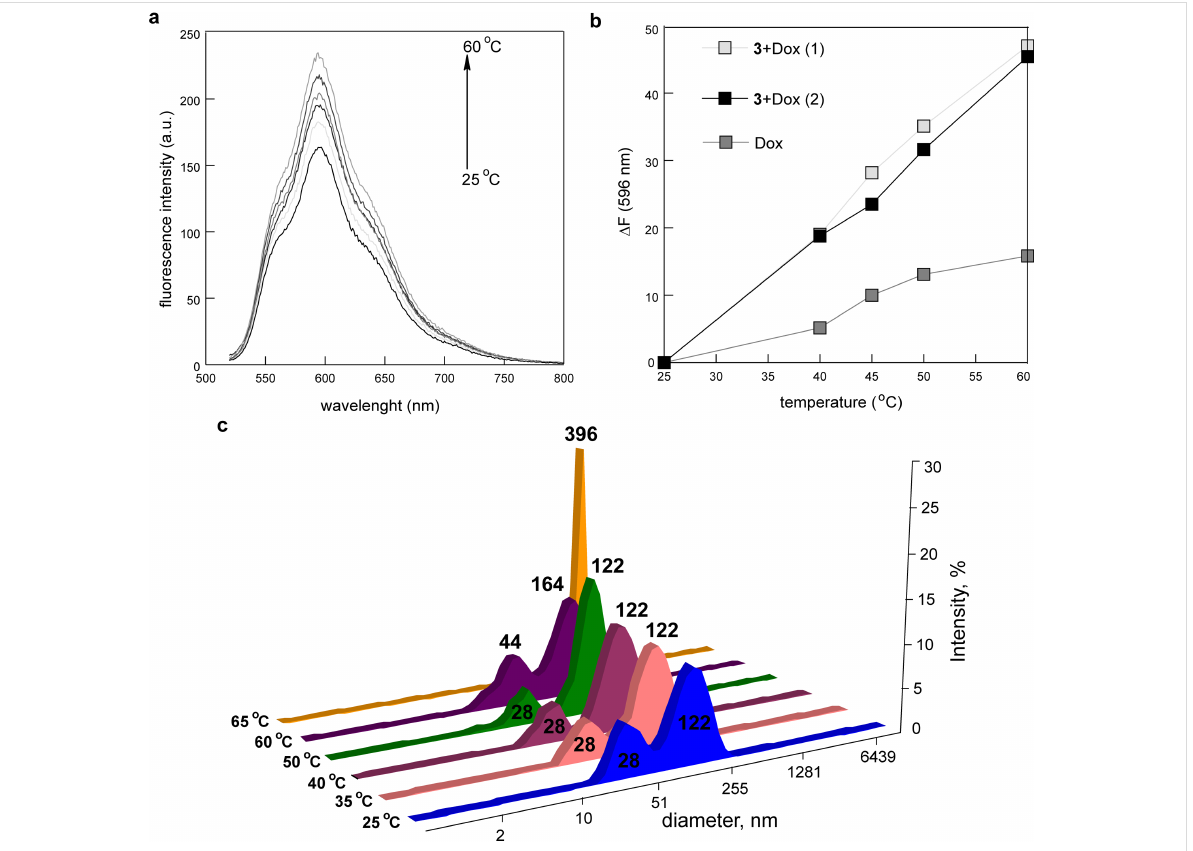
Figure 8: (a) Fluorescence spectra of Dox in micelles of 3 in 0.9% NaCl solution at different temperatures, c 3 = 3.8 mg/mL; c Dox = 0.3 mg/mL; λ ex = 500 nm, ex/em slit 5/5, voltage: 800 V; (b) Dox fluorescence intensity change at 596 nm ( Δ F ) of the pure and micellar solutions in 0.9% NaCl as a function of the temperature, c Dox = 0.03 mg/mL, (1): c 3 = 3.8 mg/mL, c Dox = 0.3 mg/mL, (2): c 3 = 30 mg/mL, c Dox = 0.44 mg/mL; (c) intensity-aver- aged particle size distribution of 3 + Dox in 0.9% NaCl solution at different temperatures, c 3 = 30 mg/mL, c Dox = 0.44